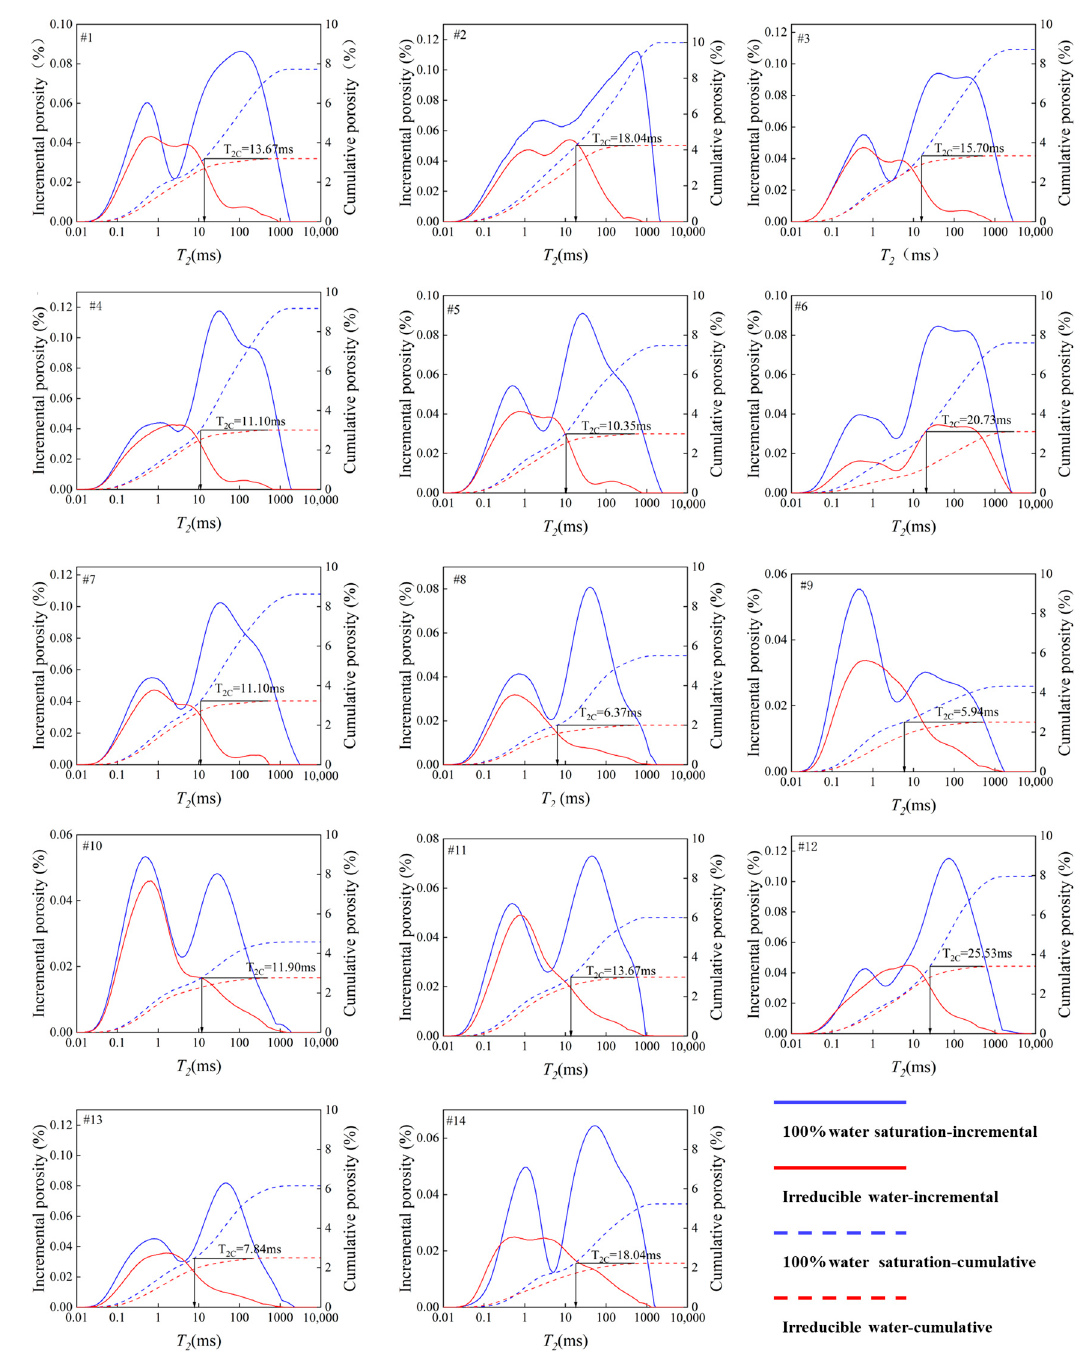
Figure 7. NMR T 2 distributions of the samples at 100% water saturation and under irreducible water conditions.